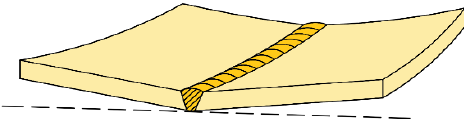
Figure 2. Angular distortion of a butt weld.